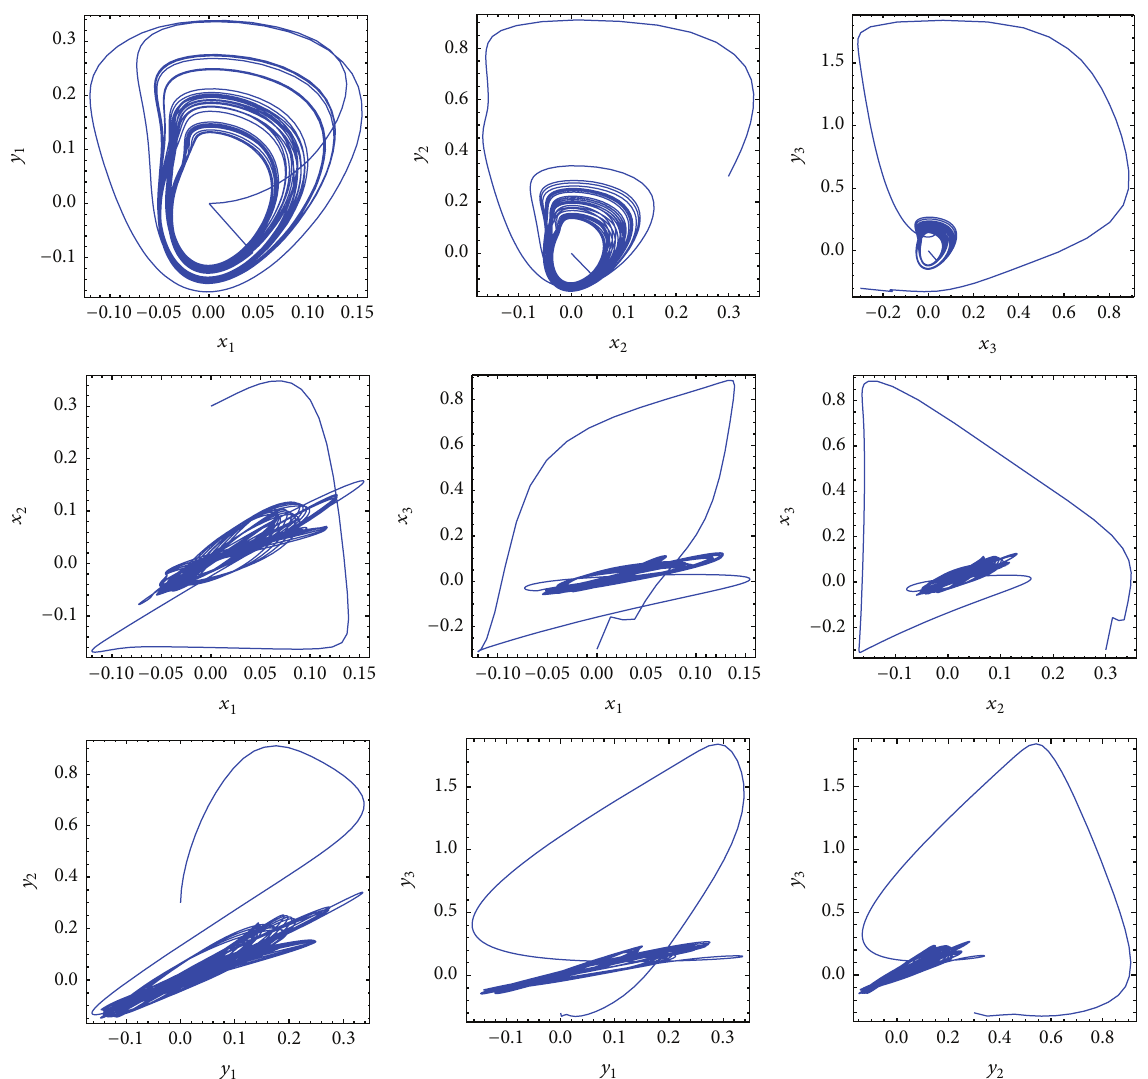
Figure 4: Phase plot of chaotic behavior of chaotic FHN neuronsis, with 𝛼 1 = 𝛼 3 = 𝛼 5 = 0.9, 𝛼 2 = 𝛼 4 = 𝛼 6 = 0.8